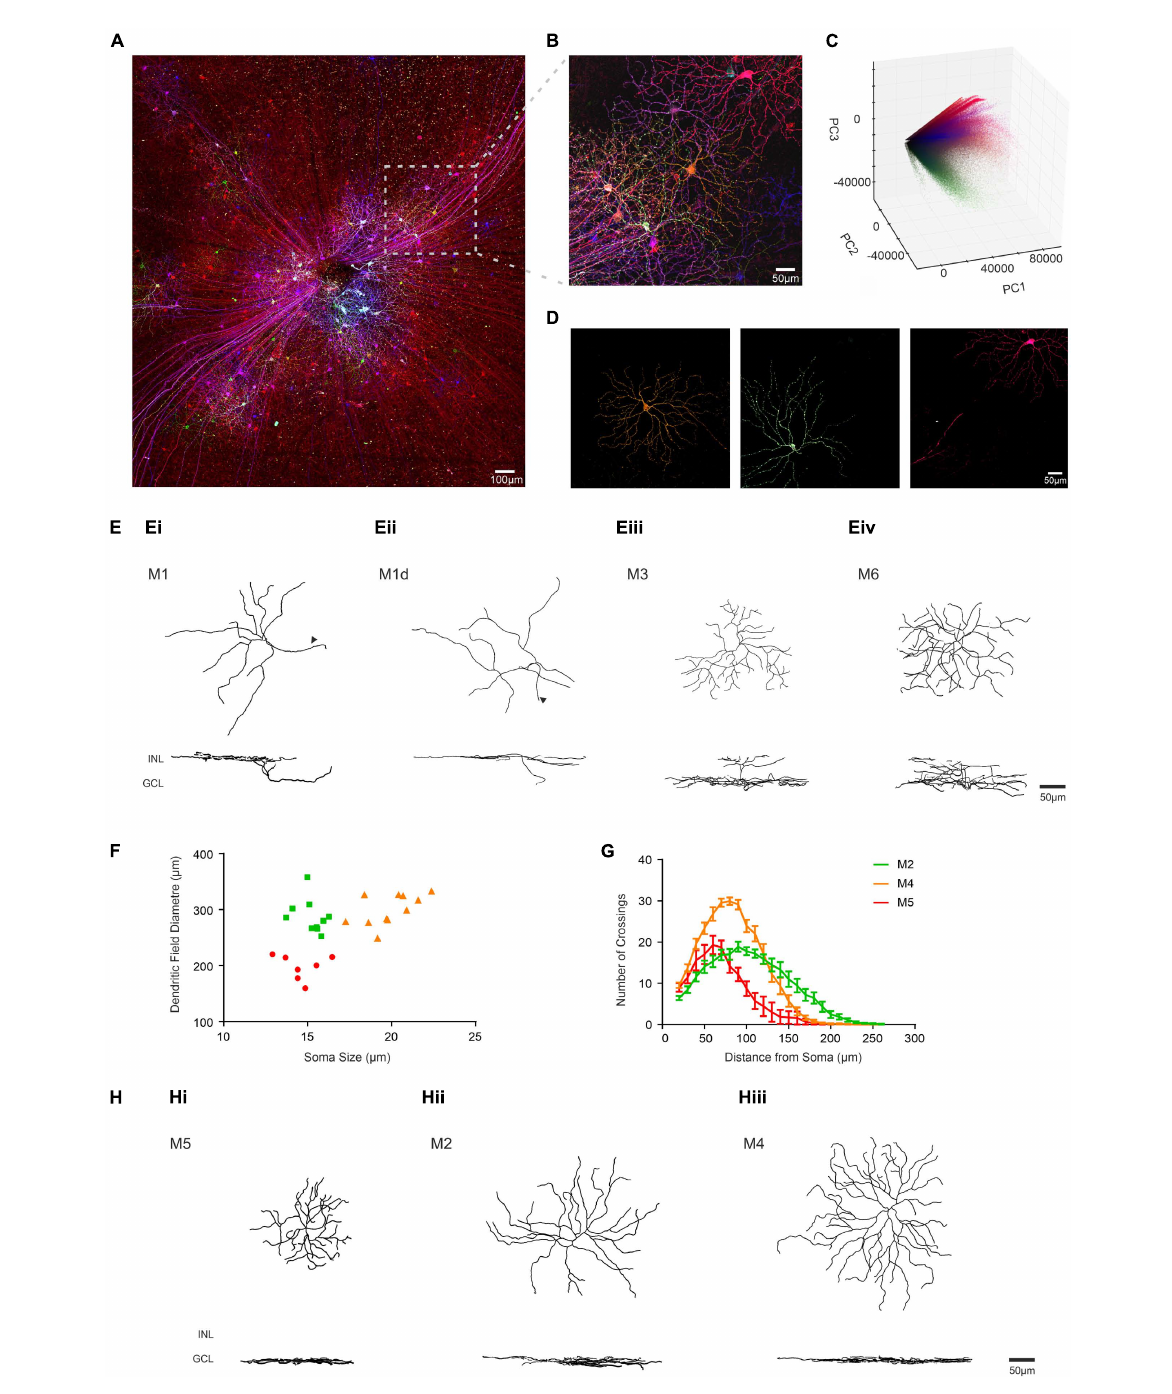
FIGURE5 Identifying ipRGC subtypes in the degenerate retina through quantitative morphological characteristics obtained using BRIAN. (A) Maximum projection of a representative wholemount retina from an Opn4 Cre / + ;rd/rd mouse unilaterally intravitreally injected with the AAV Brainbow virus, following immunohistochemical labeling for mCherry (pseudocolored red), eYFP (pseudocolored green) and mTFP (pseudocolored blue) reporter proteins. (B) Representative filtered ROI from the boxed region in panel (A) shows dense labeling of Retinal Ganglion cells